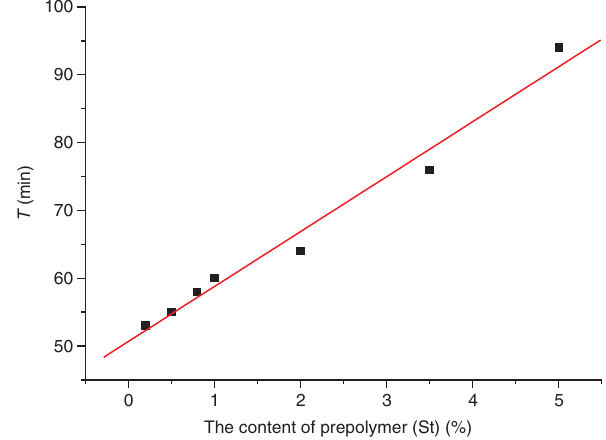
Figure 3: The relation between the pre-polymer concentration and the rate of polymerization (the pre-polymer time is 20 min; the pre-polymer temperature is 80 ° C; T is the starting time of pre-